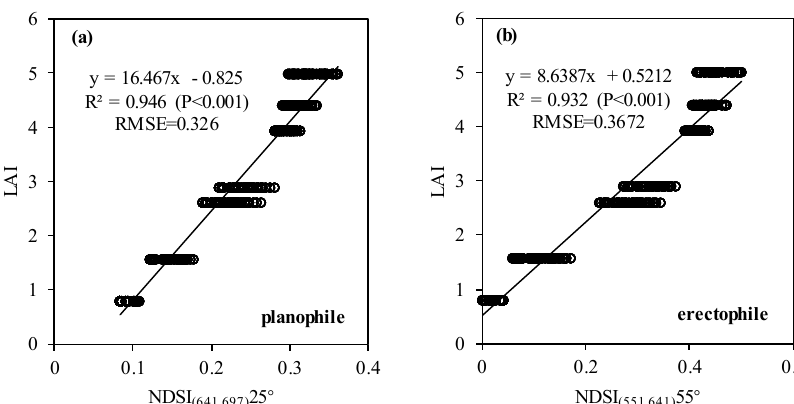
Figure 10. Optimal linear relationships between NDSI(x,y) and LAI for ( a ) the planophile and ( b ) the erectophile varieties based on the PROSAIL simulations.